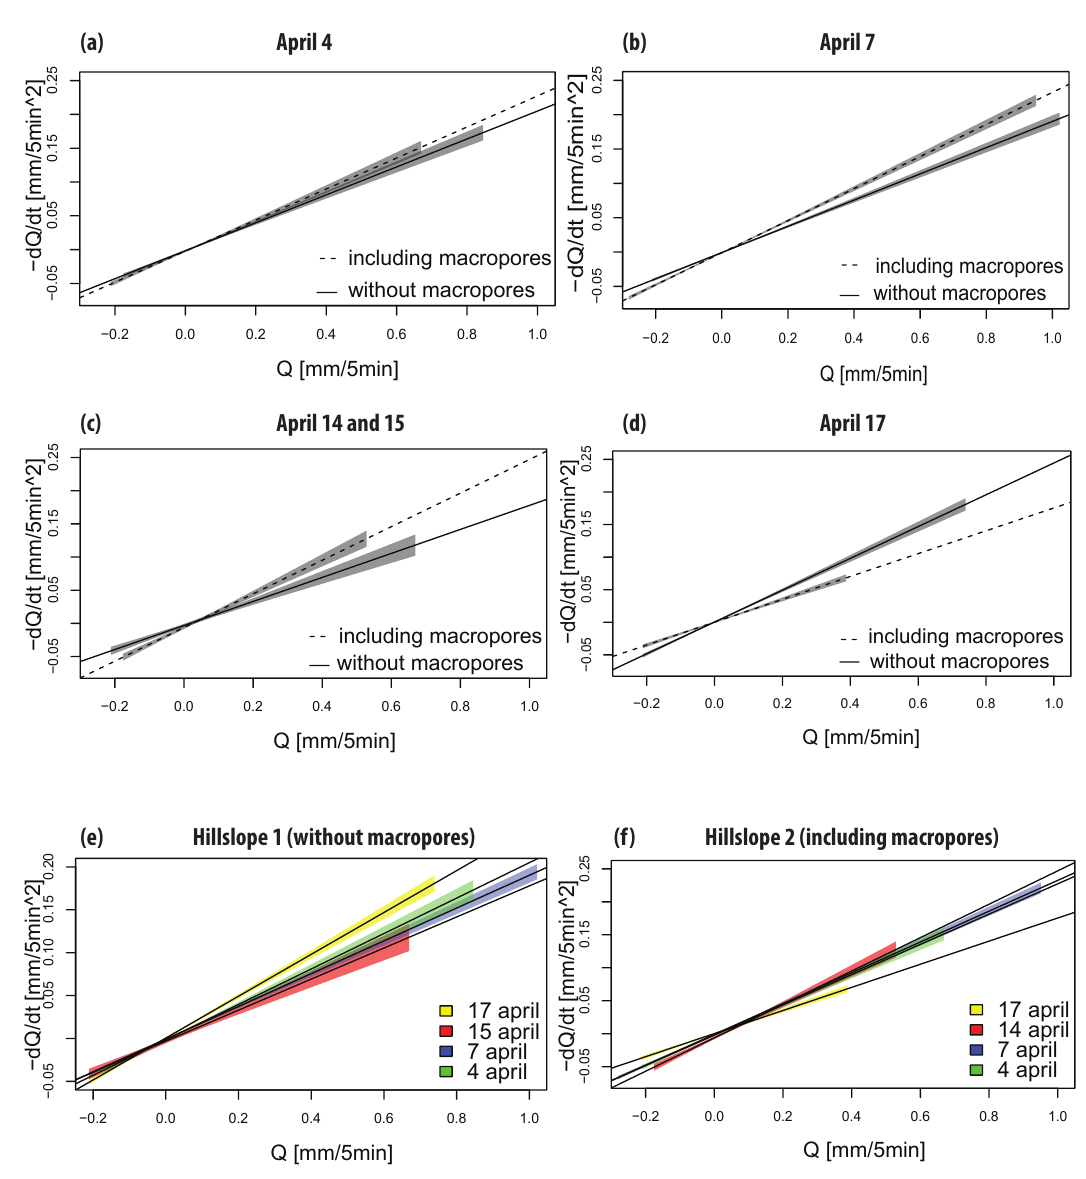
Figure 11. Comparison of drainage characteristics of the two hillslopes. ( a – d ) show the comparison of the confidence intervals for four different dates of rainless periods between hillslope 1 (without macropores) and hillslope 2 (including macropores); ( e , f ) show the comparison between the confidence intervals for four different dates per hillslope. Note that the difference between the confidence intervals of the two hillslopes is as large as the difference between the confidence intervals of each hillslope